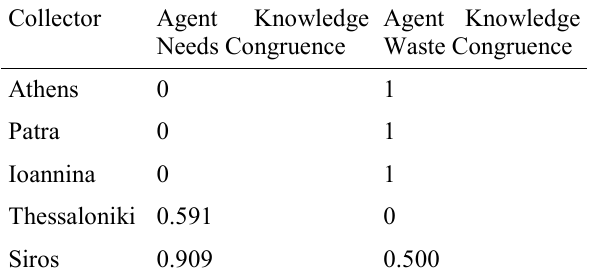
Table 5. MNA measurements